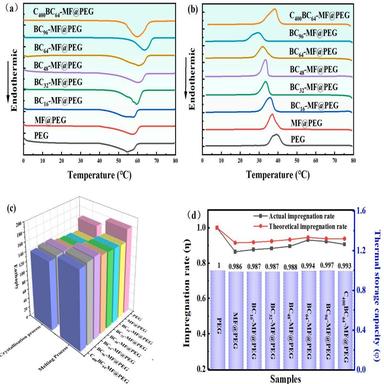
Diagrams of (a) melting process and (b) crystallization process for FCPCMs tested by DSC; (c) Enthalpy of FCPCMs; (d) Thermal storage capacity, theoretical impregnation rate and actual impregnation rate for FCPCMs.